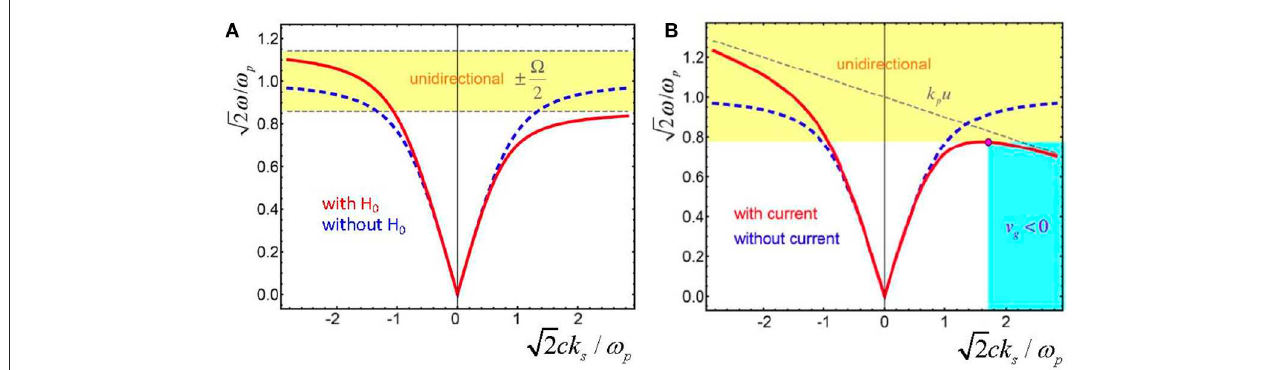
FIGURE 14 | Non-reciprocal modifications of the SPP spectra caused by (A) a transverse magnetic field, Equation (85), and (B) a longitudinal direct electric current, Equation (86) (reprinted with permission from Bliokh et al. [99] © 2018 The Optical Society). The dashed curves show the unperturbed reciprocal SPP dispersion ω 0 ( k s ) for the Drude model (73). The frequency ranges with the one-way SPP propagation and the wavevector range with the negative group velocity of SPPs are marked by yellow and blue, respectively. The parameters are (A) (cid:127) 0.2 ω p and (B) u 0.1 c = = −